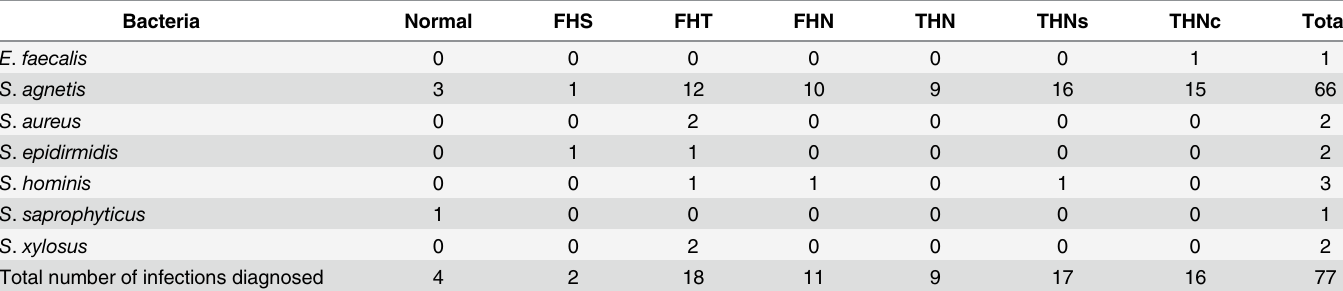
Table 2. Bacterial species from lame birds based on bone lesion.